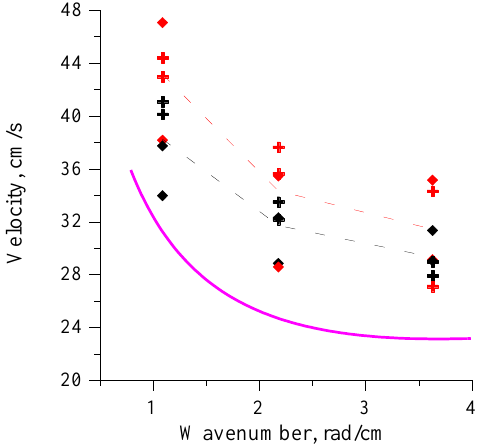
Figure 11. BC and NBC scatterer velocities (black and red symbols, respectively) for a crosswind direction. Solid line is the phase velocity of linear gravity-capillary waves. Dashed lines denote the best fit of experimental data.